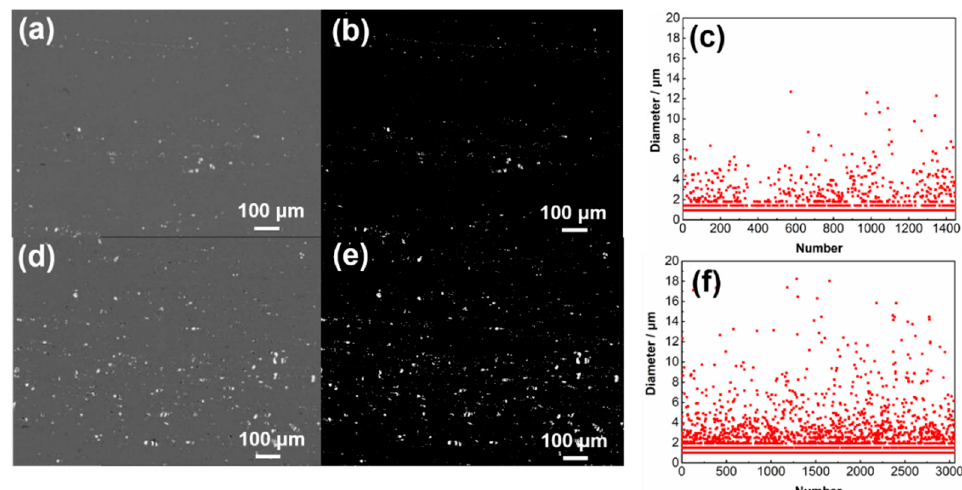
Figure 3. ( a , d ) Backscattered electron micrographs and ( b , e ) the corresponding superimposed images showing the intermetallic particles in the Low Fe ( a , b ) and High Fe alloys ( d , e ). The graphs showing the size distribution of intermetallic particles in the Low Fe ( c ) and High Fe alloys ( f ).